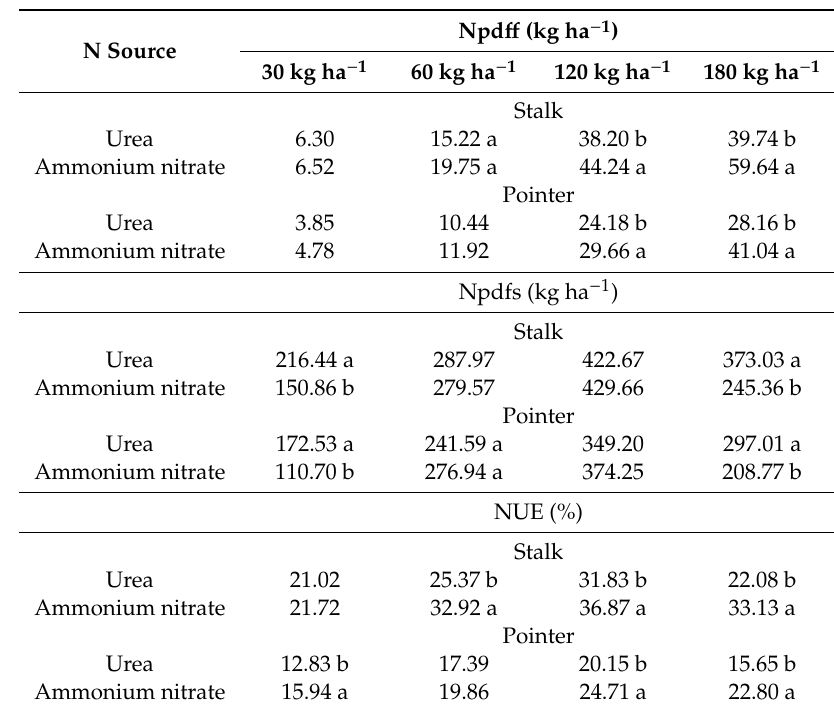
Table 3. Amount of N in sugarcane plant derived from fertilizer (Npd ff , kg ha − 1 ), amount of N in sugarcane plant derived from soil (Npdfs), and nitrogen use e ffi ciency (NUE), by sugarcane plant (stalk and pointer), in the cane plant cycle, as a ff ected by N rate as ammonium nitrate and